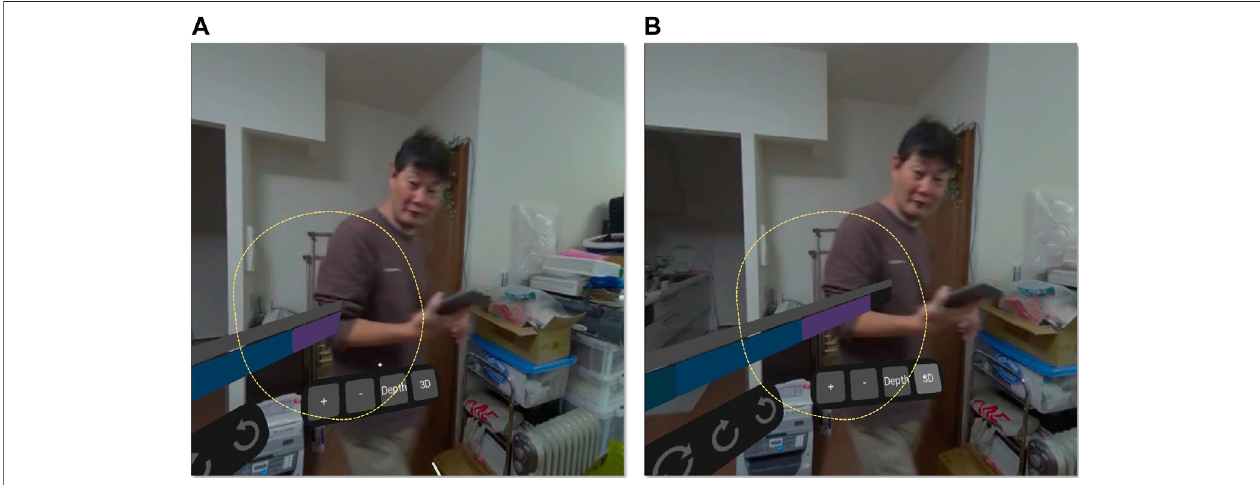
FIGURE 2 | (A) A 6DoF video is rendered in 3D, and interferes with the 3D UI elements as the draw order is speci fi ed by the depth and the UI elements disappear behindthevideoelements. (B) Thesamevideorenderedasmonoscopic360-degreevideodoesnotexhibitthisissue.Usingvideomaterialfromhttps://www.kandaovr. com/gallery/available via